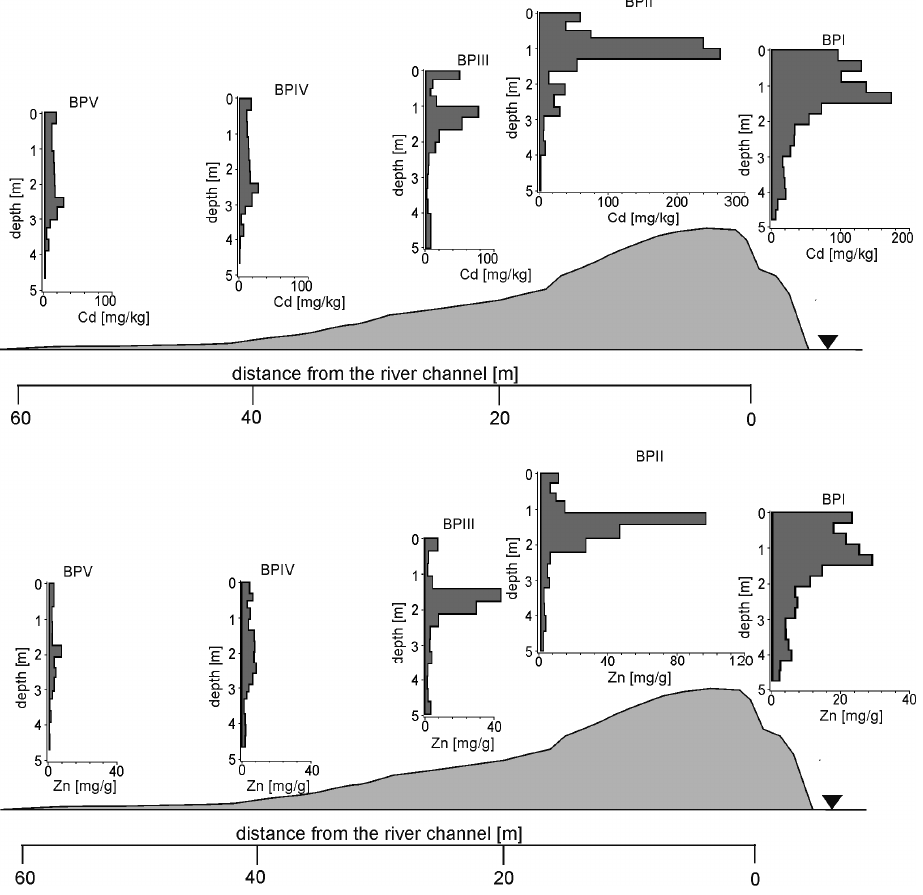
Figure 2. Distribution of Cd and Zn in < 0.063 mm fraction of floodplain sediments of the Biała Przemsza River.